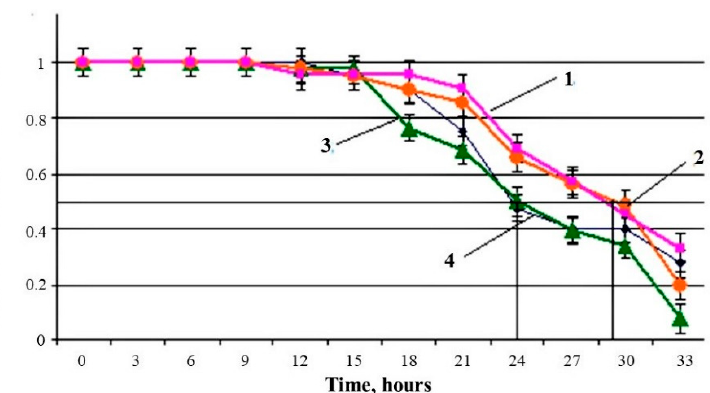
Figure 4. Changes in the median lifespan of nematodes with time under conditions of paraquat- induced oxidative stress in the presence of different concentrations of an aqueous extract of the beetle U. dermestoides : (1) 10% of total sample volume; (2) 2.5%; (3) 1%; (4) control.